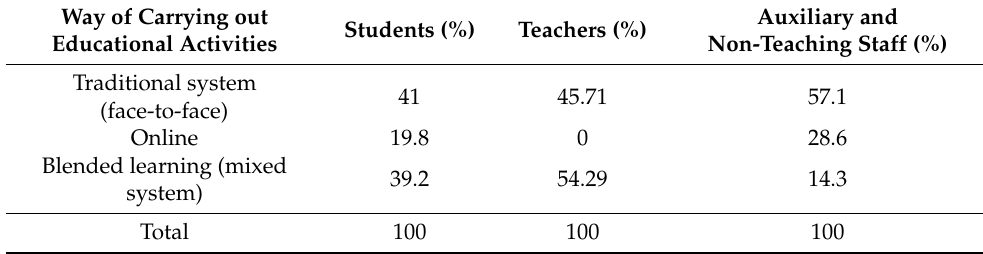
Table 13. The best way to carry out the educational